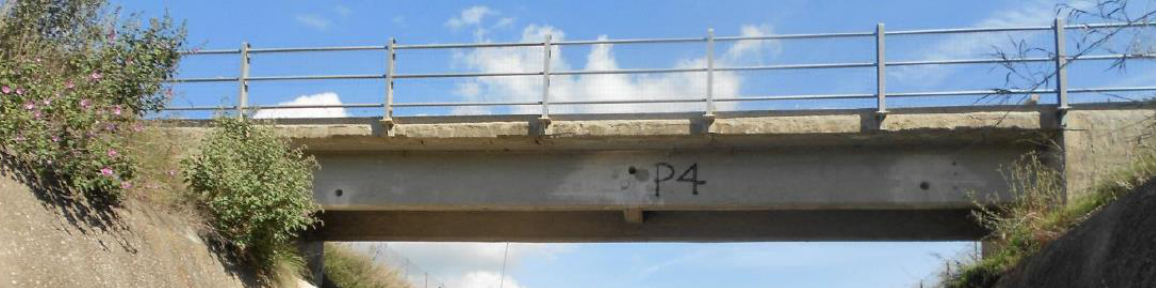
Figure 2: T1 type bridge.